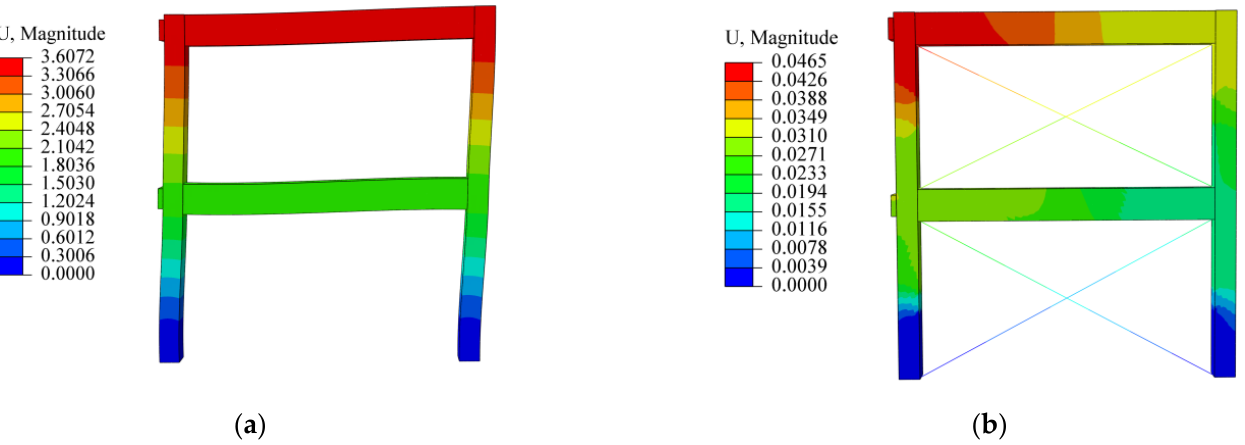
Figure 10. Under the load of 40 kN: ( a ) deformation diagram of K-1; ( b ) deformation diagram of K-3.